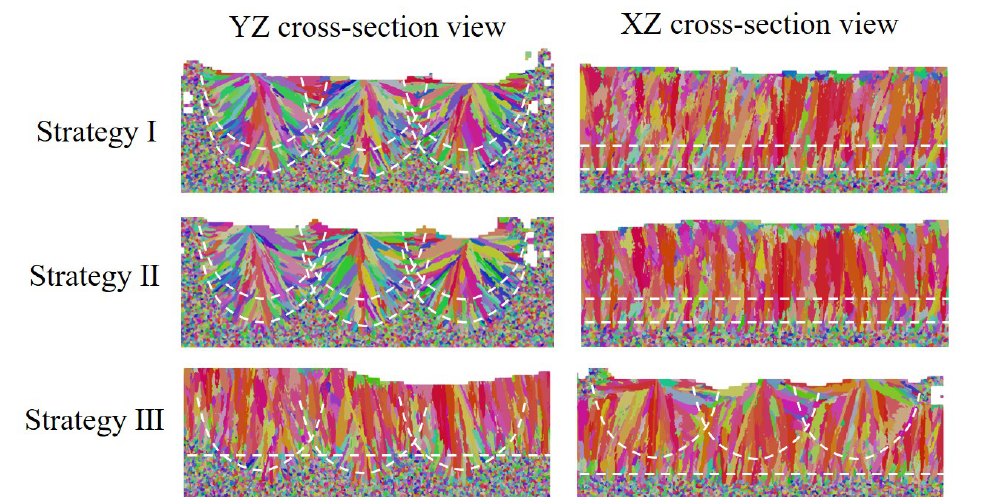
Figure 20. Cross section of simulation results of microstructure evolution under different scanning strategies, where white dotted lines represent the boundary of the fusion